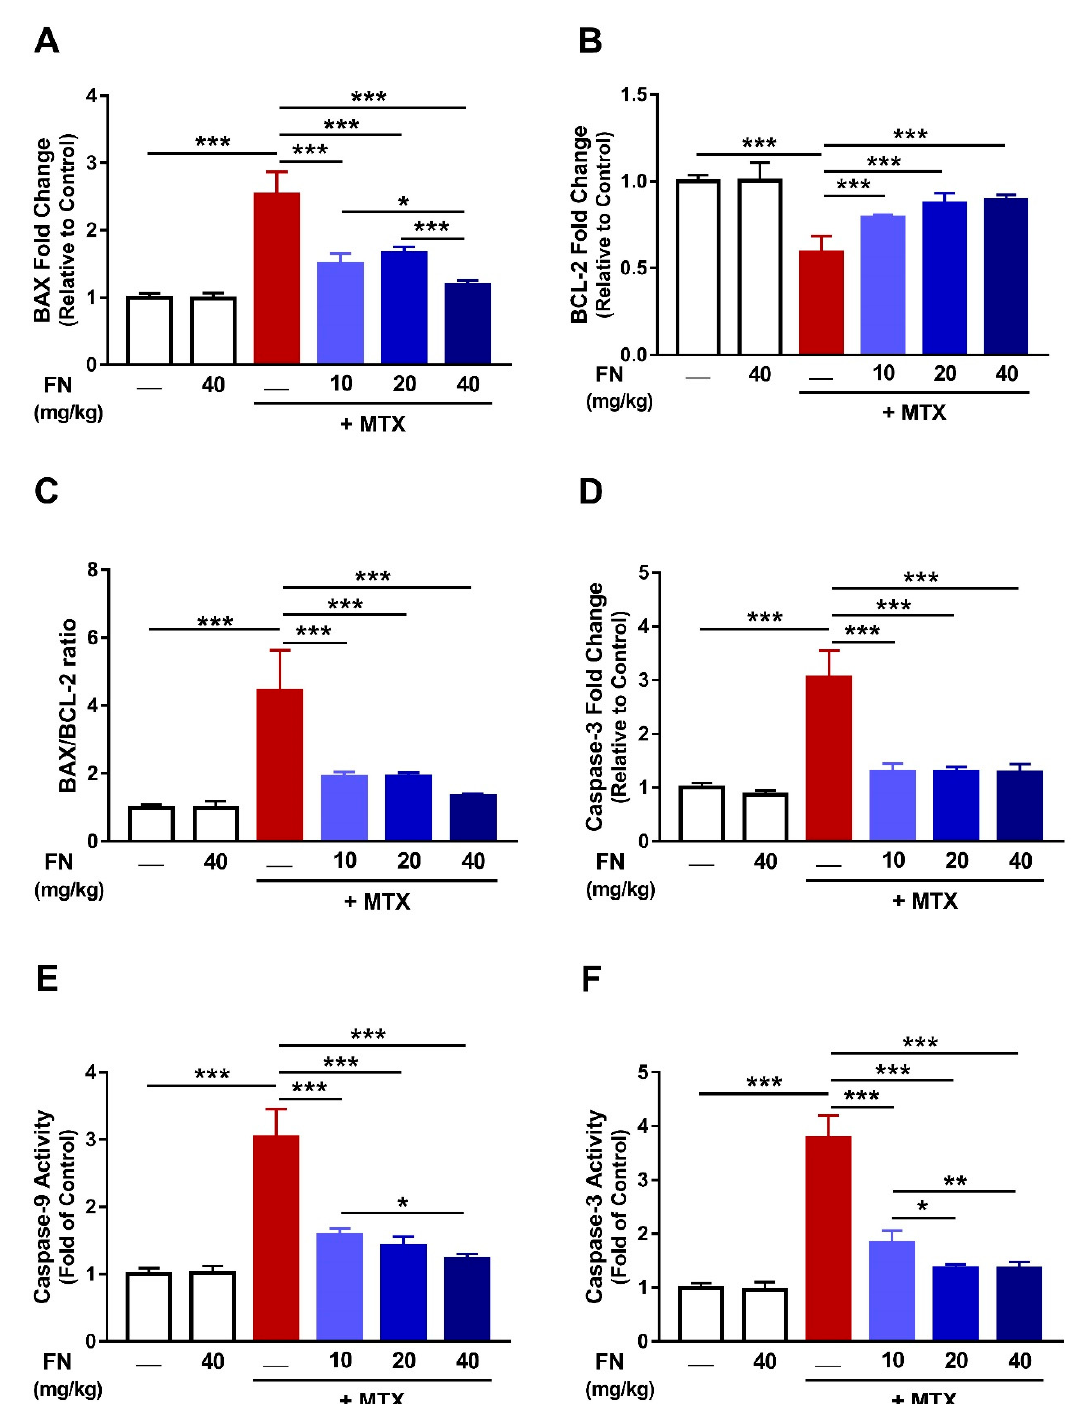
Figure 7. FN prevents MTX-induced apoptosis. FN decreased mRNA of Bax ( A ) and increased Bcl-2 expression ( B ) in the kidney of MTX-administered rats. Bax / Bcl-2 ratio ( C ), caspase-3 mRNA ( D ), caspase-9 activity ( E ), and caspase-3 activity ( F ) were decreased in rats which received FN before MTX. Data are mean ± SEM, ( n = 6). * p < 0.05, ** p < 0.01 and *** p <